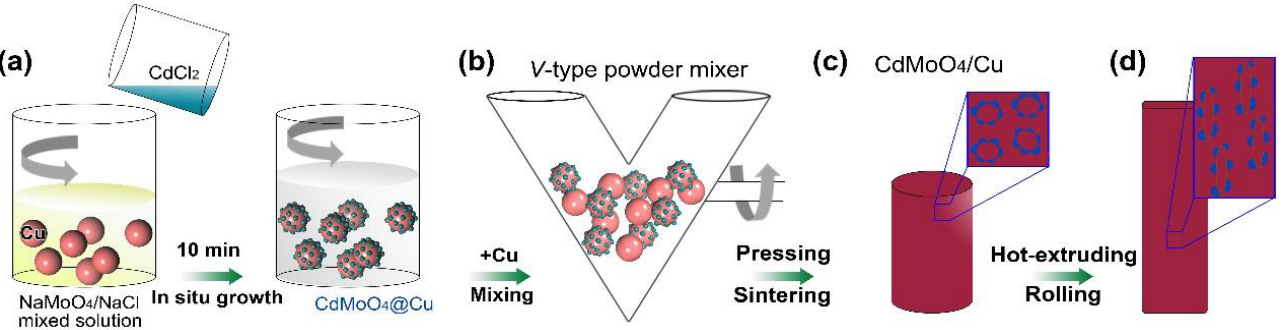
Figure 1. Schematic diagram of the fabrication of ( a ) CdMoO 4 /Cu mixed powders by an in situ method and ( b – d ) CdMoO 4 /Cu composites by powder metallurgy. method and ( b – d ) CdMoO 4 /Cu composites by powder